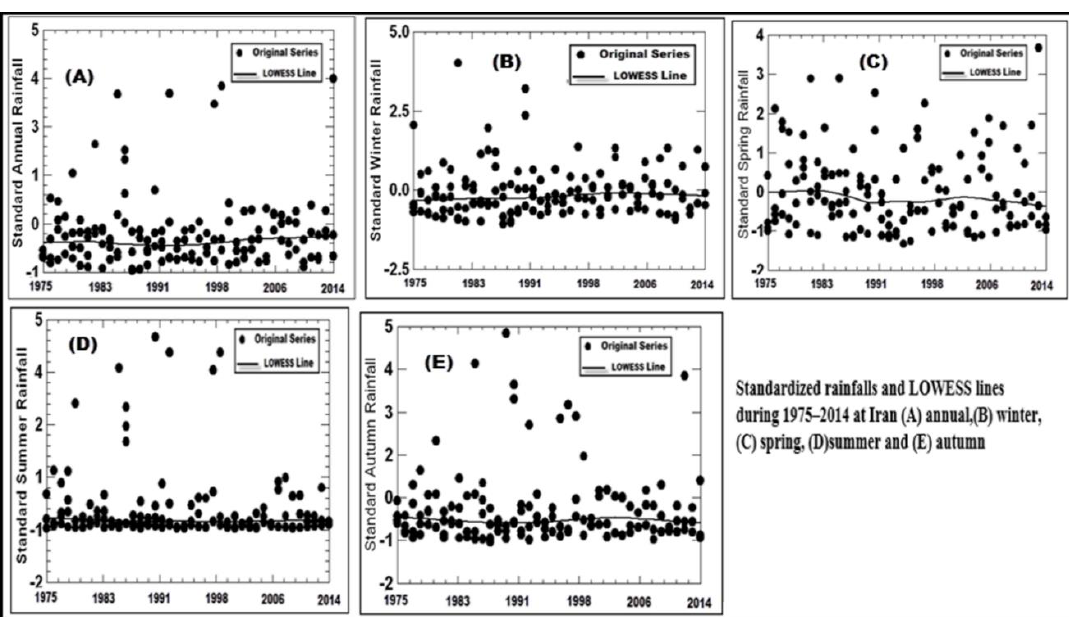
Figure 3. Standardized rainfall series and LOWESS lines during 1975–2014 in Iran ( A ) annual; ( B ) winter; ( C ) spring; ( D ) summer and ( E ) autumn.